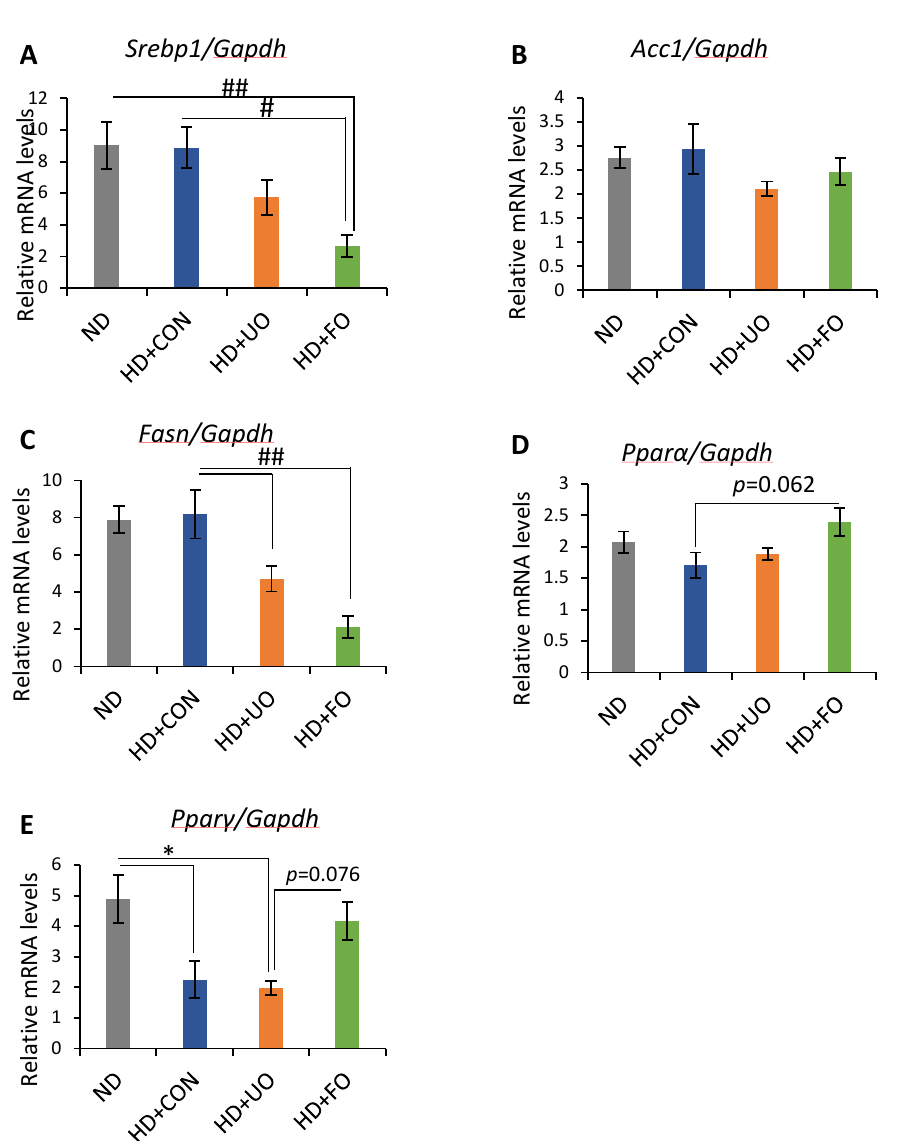
Figure 6. Gene expression levels in the liver. Relative RNA expression levels of fatty acid metabolism-related genes in the livers: Srebp1 ( A ), Acc1 ( B ), Fasn ( C ), Ppar α ( D ), and Ppar γ ( E ). Data are represented as mean ± SEM (ND, HD + CON, HD + UO: n = 6, HD + FO: n = 7) * p < 0.05 evaluated using one-way ANOVA with Tukey’s post hoc test. # p < 0.05, ## p < 0.01 evaluated using the Kruskal–Wallis test with Dunn’s post-hoc test.